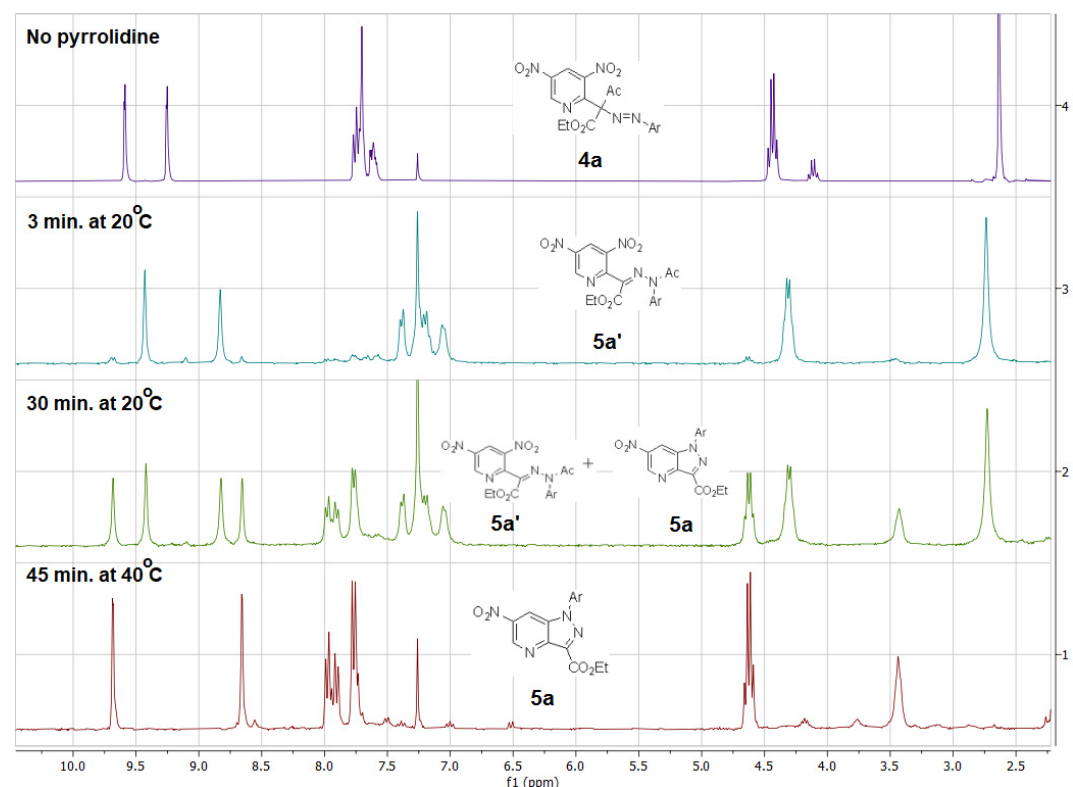
Figure 4. NMR spectra of the reaction mixture aliquots, collected and quenched before addition of pyrrolidine (violet) and then 3 (aquamarine), 30 (green) and 45 min (red) after addition.